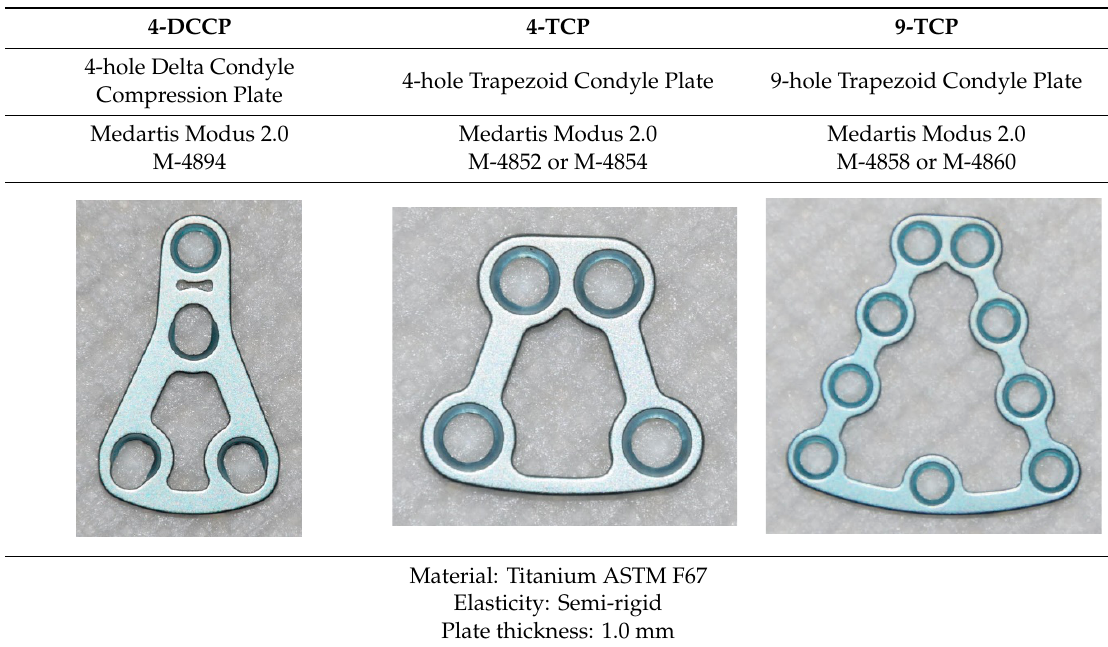
Table 4. Characteristics of 3D plates used in the study.